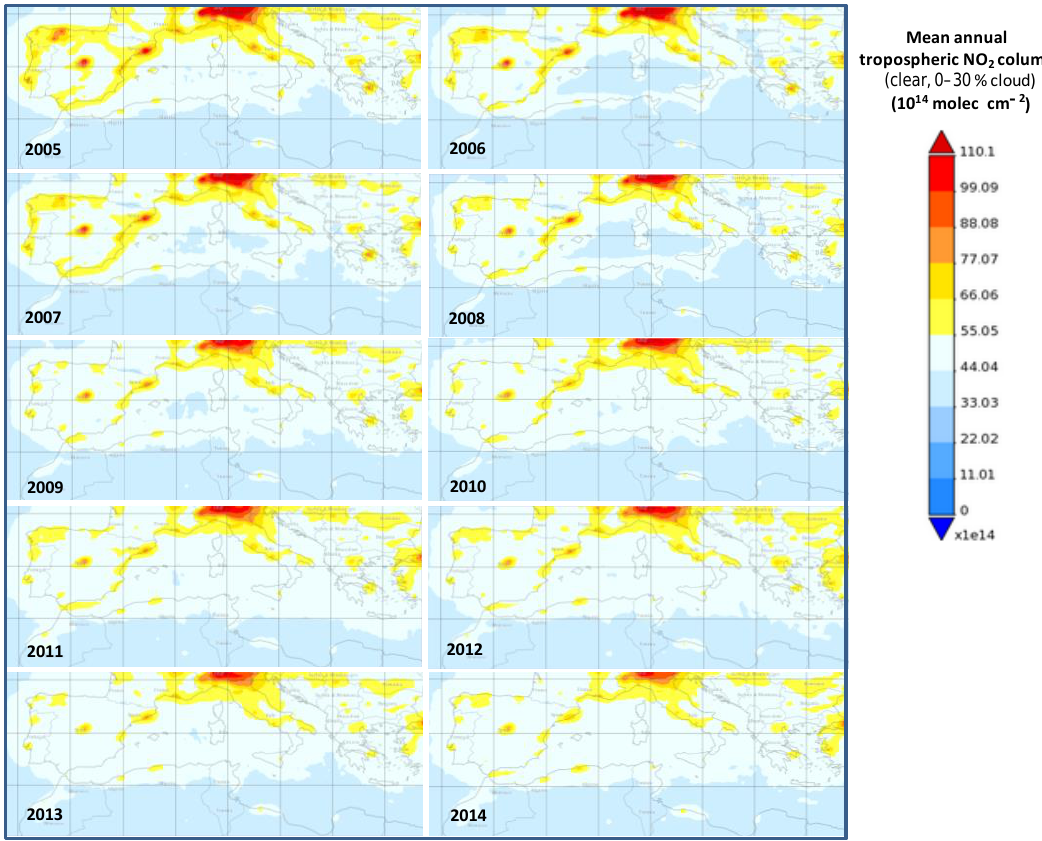
Figure 9. NASA OMI Level 3 tropospheric NO 2 column plotted using the Giovanni online data system, developed and maintained by the NASA GES DISC.